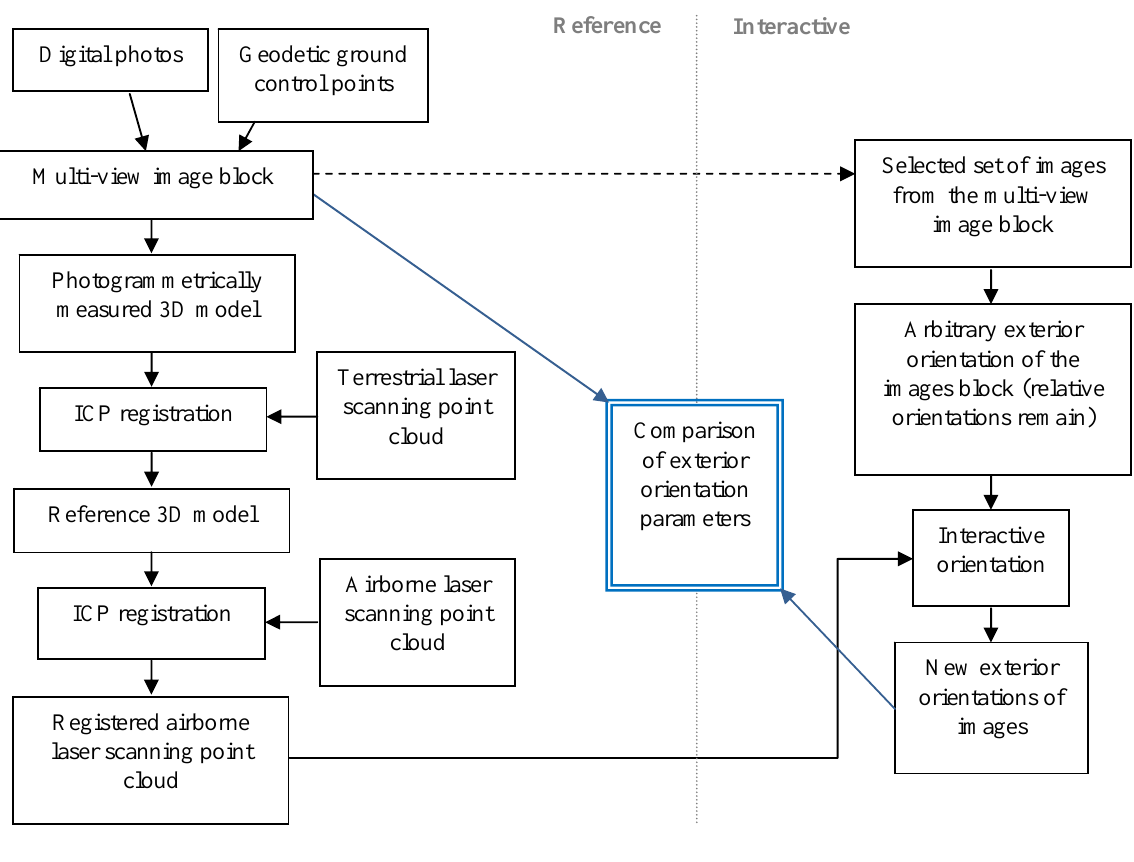
Figure 2. The workflow of the